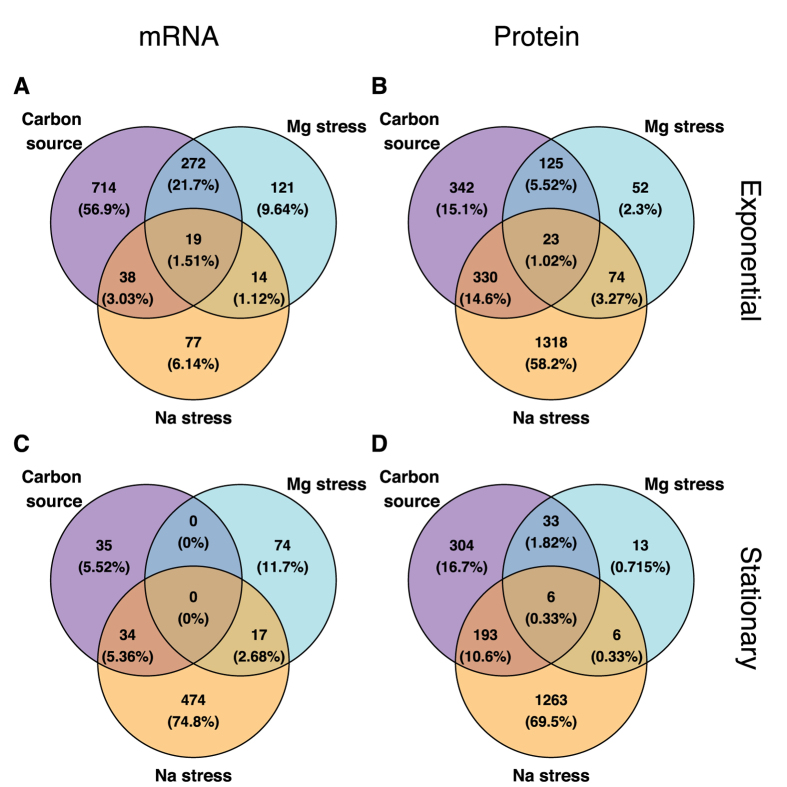
Overlap of differentially expressed genes among conditions.For all differentially expressed genes (identified as in Fig. 5), we determined to what extent they were unique to specific conditions or appeared in multiple conditions. For simplicity, we here lumped all carbon-source experiments, all sodium experiments, and all magnesium experiments into one group each. Overall, we found relatively little overlap in the differentially expressed genes among these conditions. (A) mRNA, exponential phase. (B) protein, exponential phase. (C) mRNA, stationary phase. (D) protein, stationary phase.